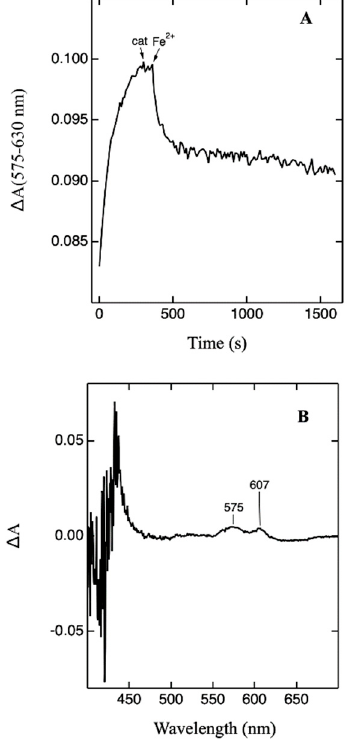
Figure 6. One-electron reduction of the F • form. ( A ) Kinetics of the development of the F • state from the oxidized CcO (49 µ M) in the reaction with H 2 O 2 (48 µ M) and its reduction by potassium ferrocyanide recorded using the absorbance change ∆ A(575- 630 nm). At times indicated by arrows, the catalase (cat, 4.7 µ M) and ferrocyanide (Fe 2+ , 9.9 µ M) were injected into the sample. ( B ) The difference spectrum was calculated between the spectrum collected before and after the addition of ferrocyanide (500s). Conditions of measurement: 39 mM potassium phosphate pH 5.7, 12.5 mM K 2 SO 4 , 7.2 µ M of oxidized cytochrome c , SOD 300 units/mL, 0.6% DM 5 ◦ C.